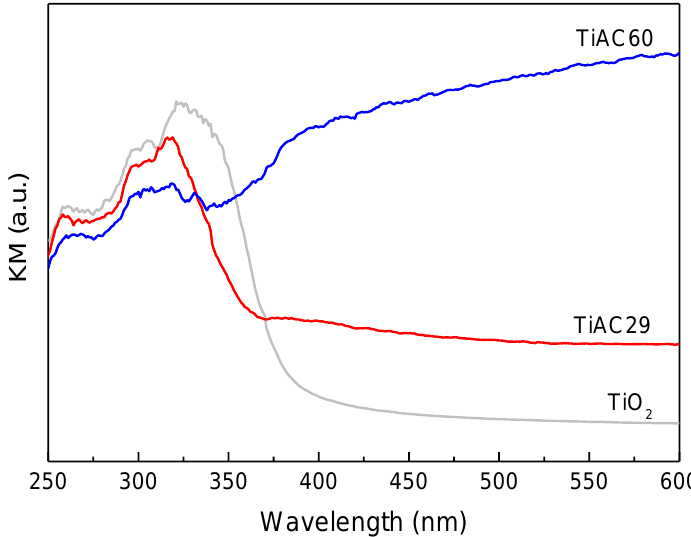
Figure 8. Diffuse reflectance spectra of bare TiO 2 and composites.